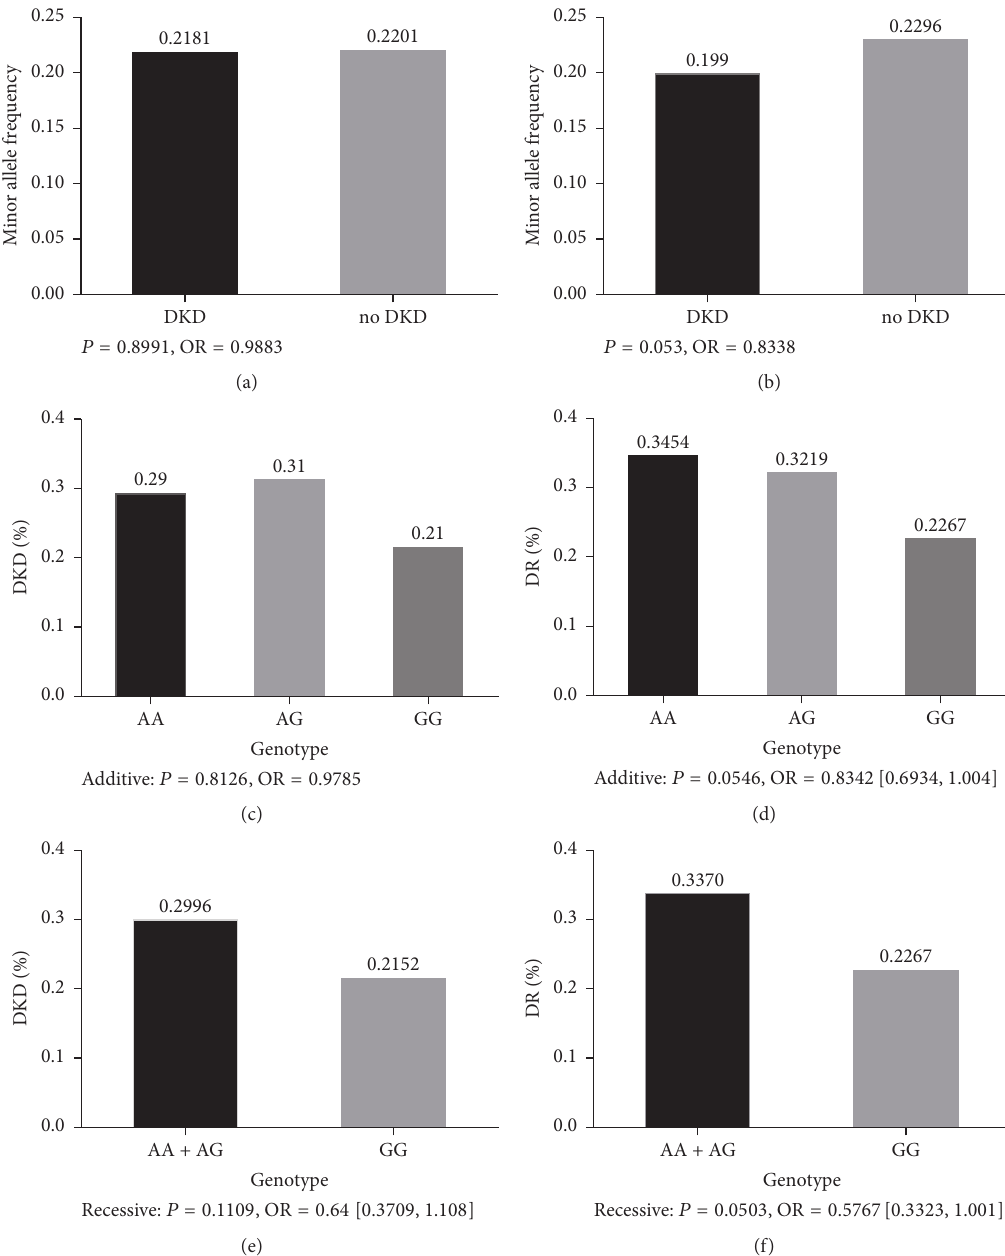
Figure 1: Allele frequency and prevalence rate in DKD and DR case-control study. (a) and (b) represent the association analysis in two case- control groups. The histograms represent the frequency of rs955333[G]. (c) and (d) represent the difference of prevalence rate in different genotypes on additive model. The histograms represent the prevalence rate. (e) and (f) represent the difference of prevalence rate in different genotypes on recessive model. The histograms represent the prevalence